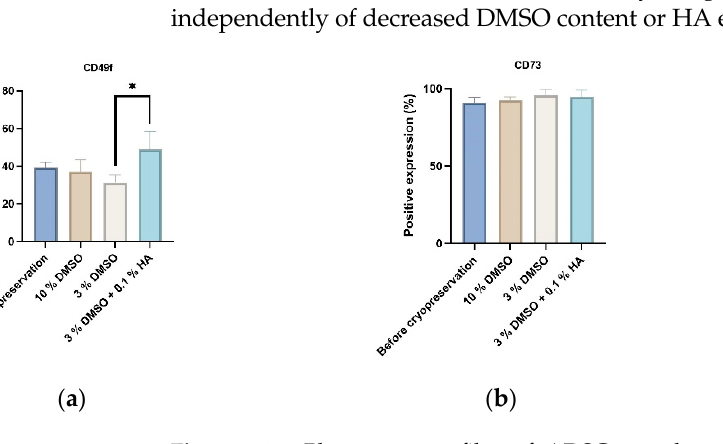
Figure 14. Phenotype profiles of ADSCs, evaluated after and prior to and 2 weeks post-cryopreservation. The layouts of graphs illustrate percentages of positive cells, determined as the percentage with a fluorescence intensity greater than 99.5% of the negative isotype immunoglobulin control. Data are presented as a mean and SD plotted as error bars. The statistical significances (* p < 0.05) were calculated using one-way ANOVA, followed by Dunnett’s multiple comparison test for continuous variables.